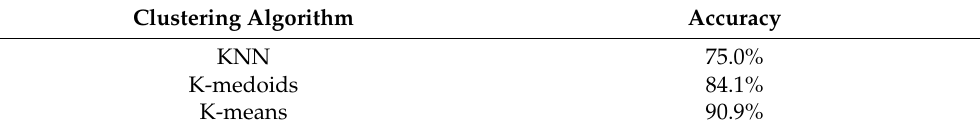
Table 5. Clustering accuracy.